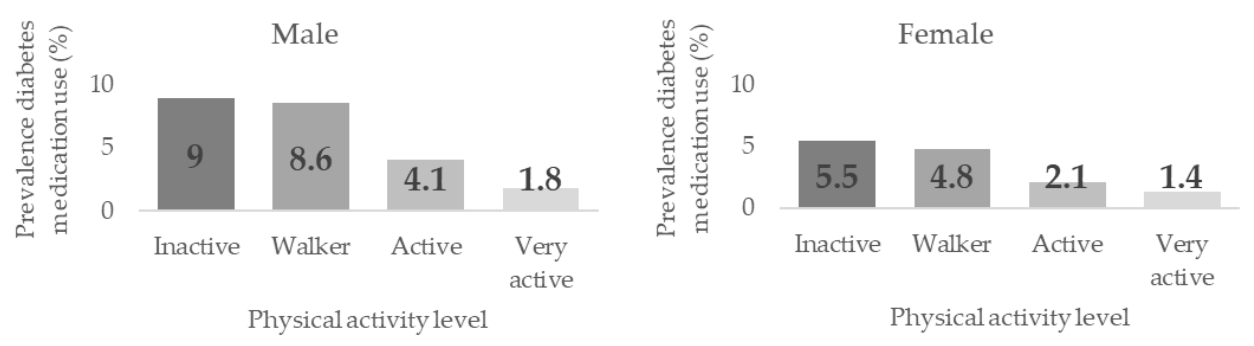
Table 5. Diabetes Risk According to the Physical Activity Level.